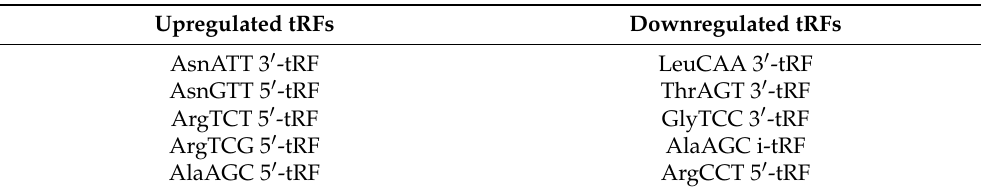
Table 1. tRFs Associated with LUSC Primary Tumor Samples.